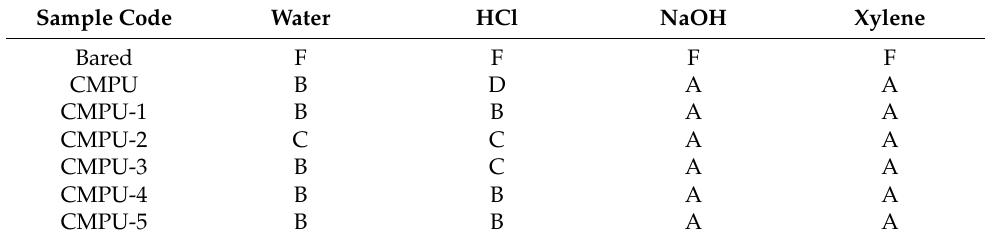
Table 4. Chemical resistance of bared, CMPU, CMPU-1, CMPU-2, CMPU-3, CMPU-4, and